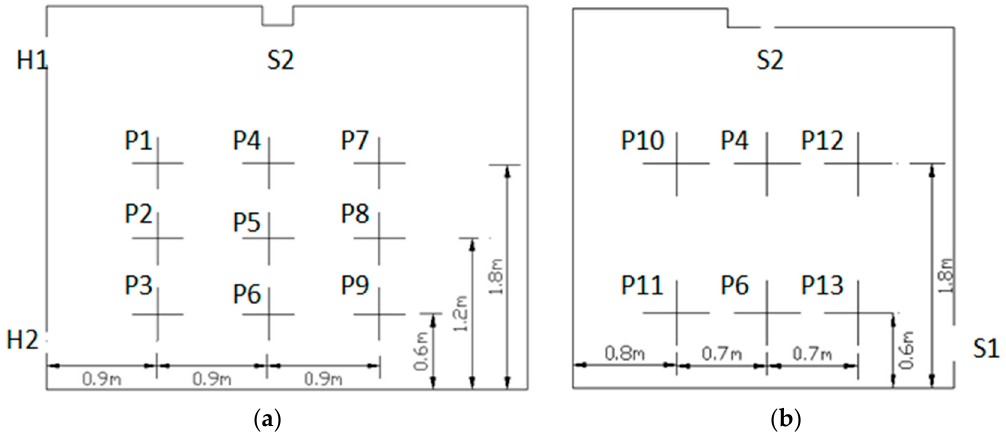
Figure 2. Detailed locations of the measurement points: ( a ) Plane X = 1.5 m; ( b ) plane Y = 1.8 m.